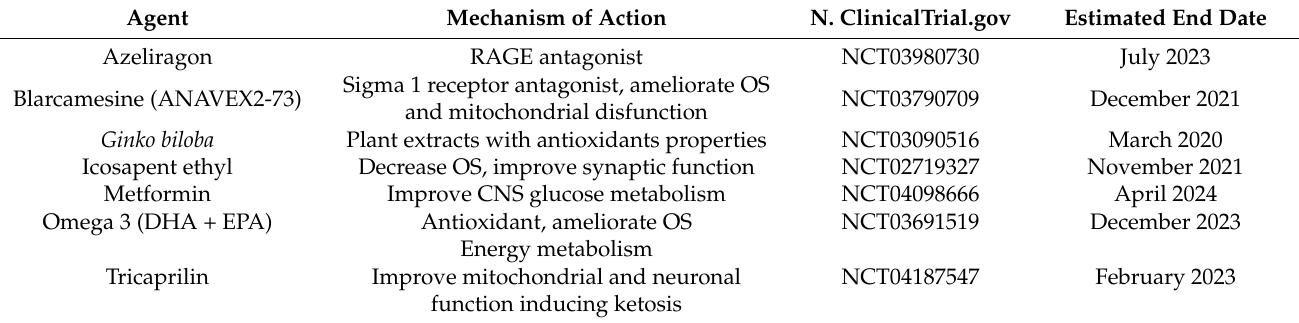
Table 2. Summary table of phase 3 clinical trials with agents related to OS mechanism of action or antioxidant properties in patients with